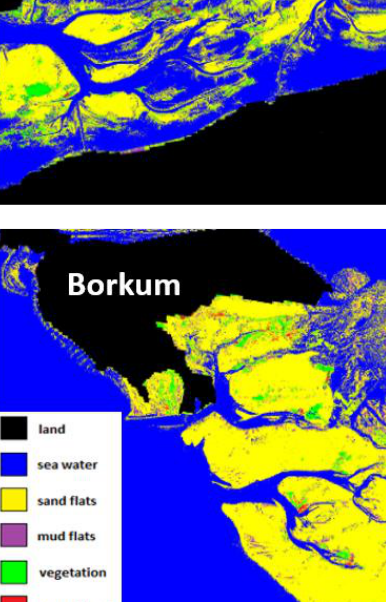
Figure 4. Classification results of FCD-RF classification scheme for test site ‘Norderney’ and ‘Amrum’ for C-band, ‘Spiekeroog’ and ‘Borkum’ for X-band.